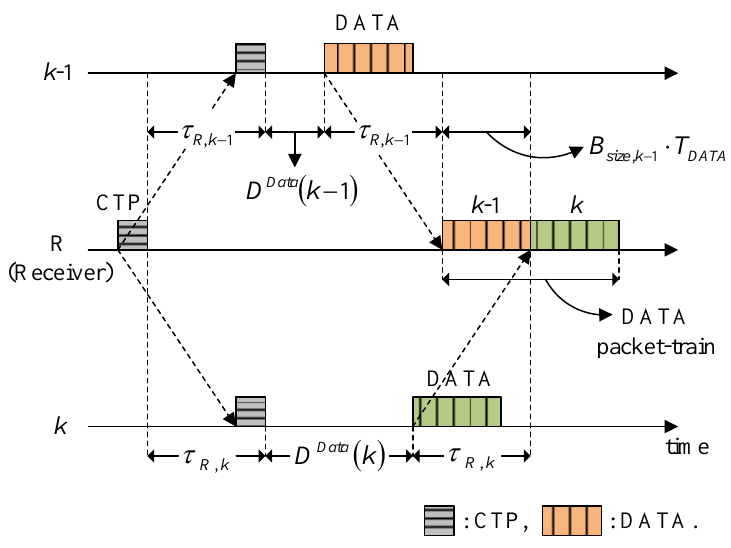
Figure 8. Determination of the Delay for data